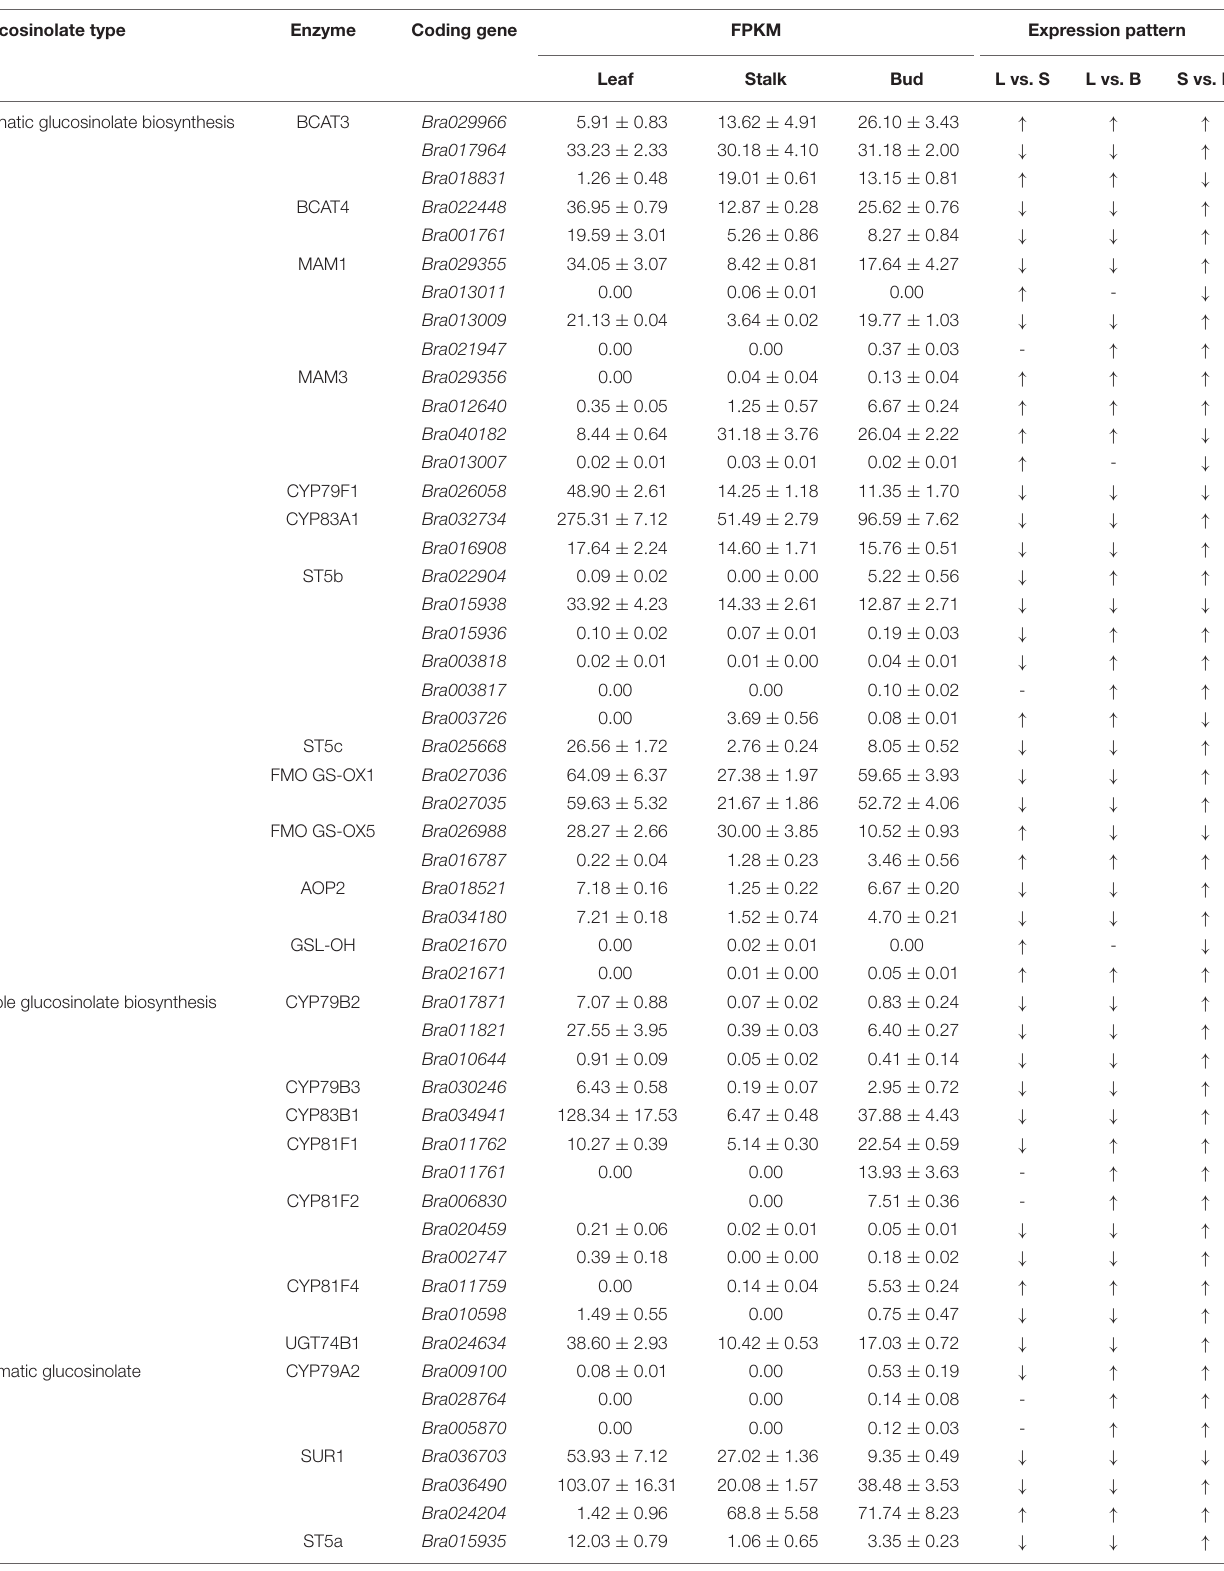
TABLE 2 | Expression of genes encoding enzymes involved in glucosinolate metabolism. Glucosinolate type Enzyme Coding gene FPKM Expression pattern Leaf Stalk Bud L vs. S L vs. B S vs.